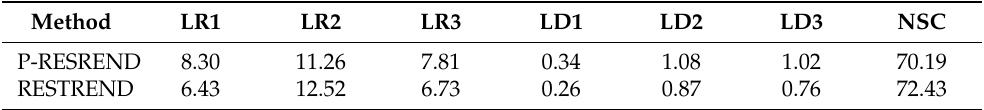
Table 2. Percentage of pixels among the seven different categories detected by P-RESRTREND and RESTREND.